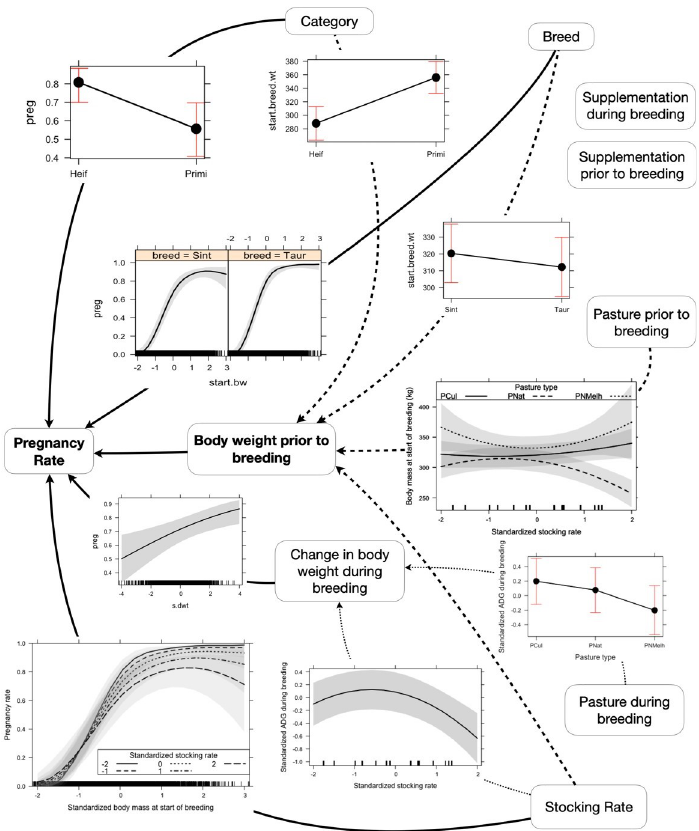
Fig 6. Schematic representation of modeling results showing effects of animal factors (category and breed type), foraging environment (pasture type, stocking rate and supplementation) on body weight and reproductive performance of beef cattle. Full lines represent direct effects, dotted lines represent indirect effects through change in body weight during breeding, and dashed lines represent indirect effects through body weight prior to breeding. Absence of a line indicates the factor was not included in the final